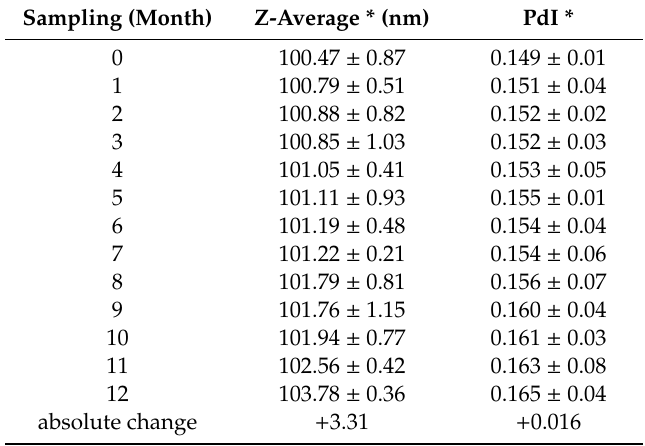
Table 6. Results of DLS measurements after 12 months of physical-stability examination.